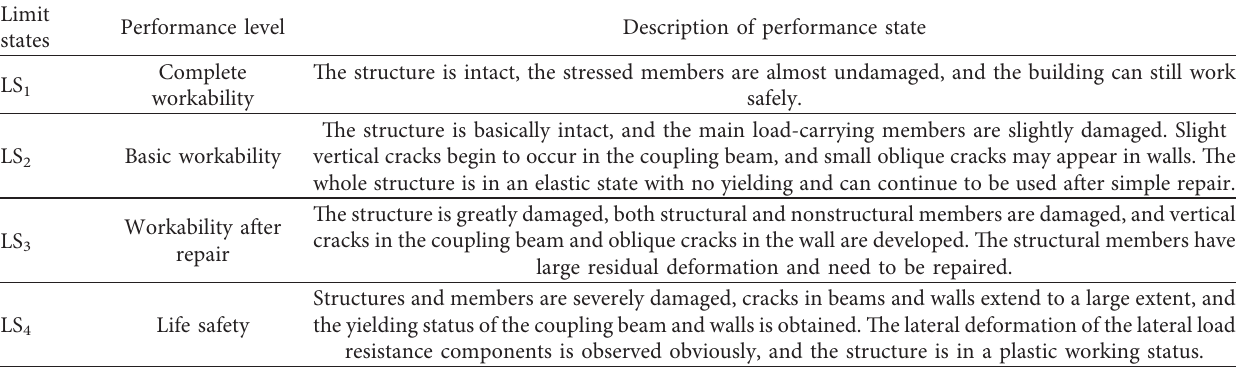
Table 6: Limit states and its corresponding description of the performance state.